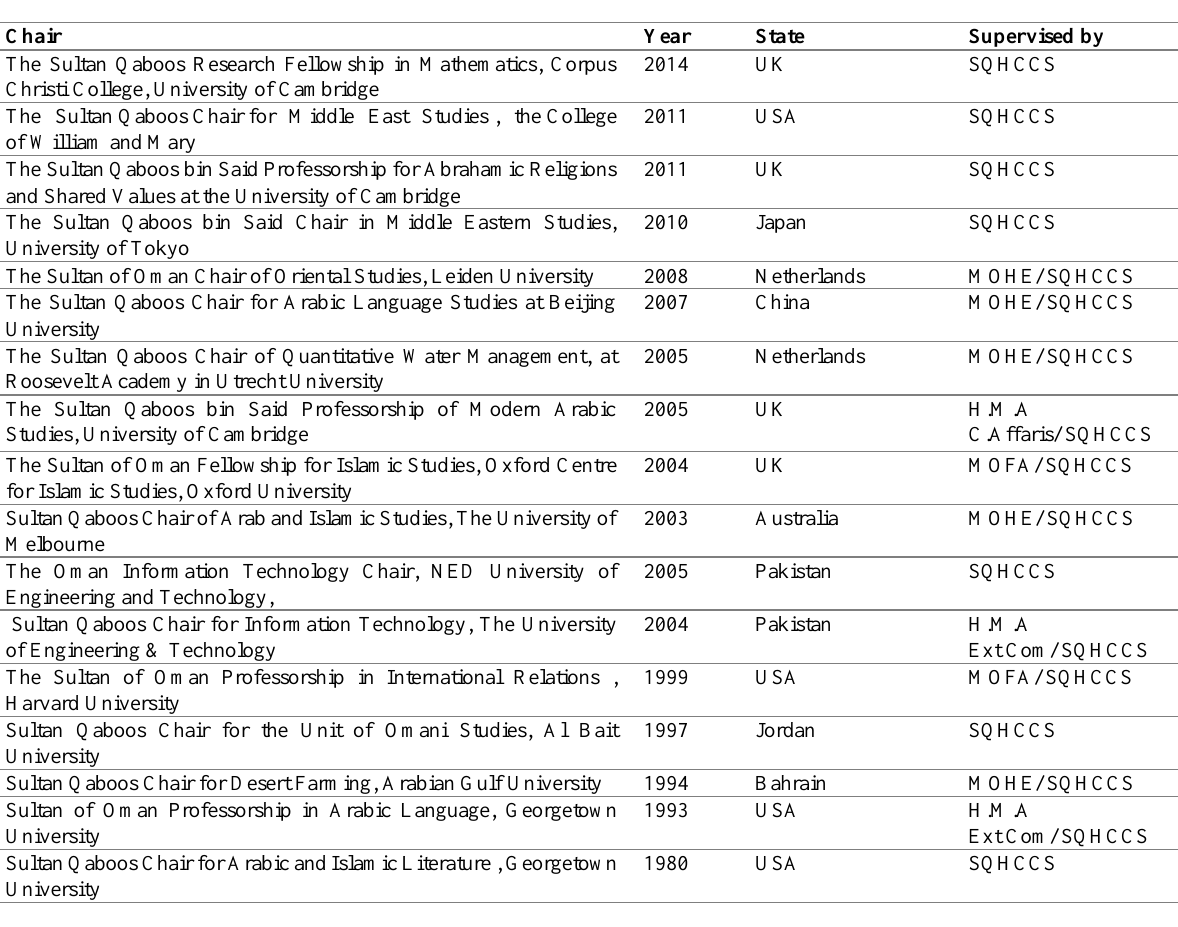
Table 4: Sultan Qaboos Scientific Chairs (Manipulated by the